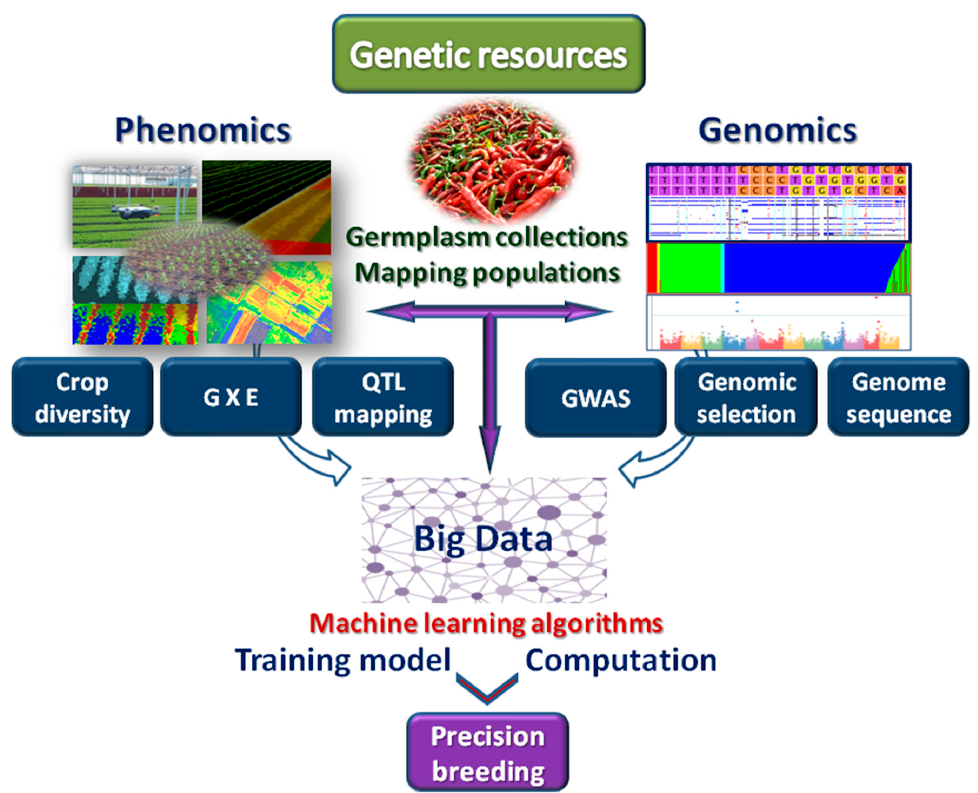
Figure 2. Integration of genomics and phenomics for the exploitation of genetic resources in genome wide association studies (GWAS), genotype by environment (GxE) estimation, quantitative trait loci (QTLs) analysis, investigation of crop diversity and genomic selection. Related big data are exploited in ML-based algorithms implemented in computational tools leading to precision breeding.